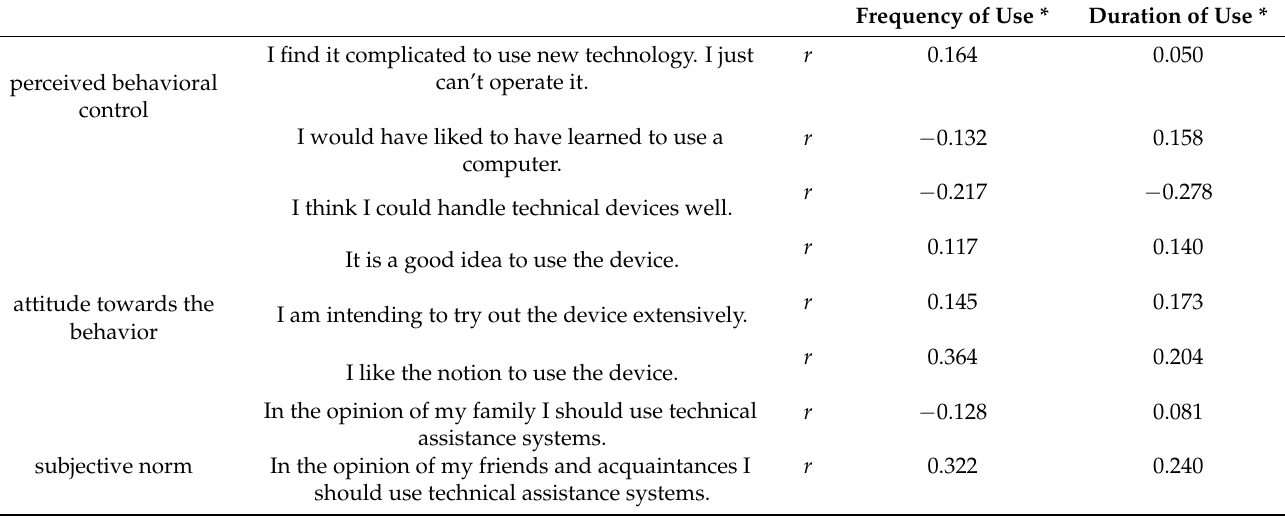
Table 3. Correlation between TRA/TPB-scores, duration and frequency of app